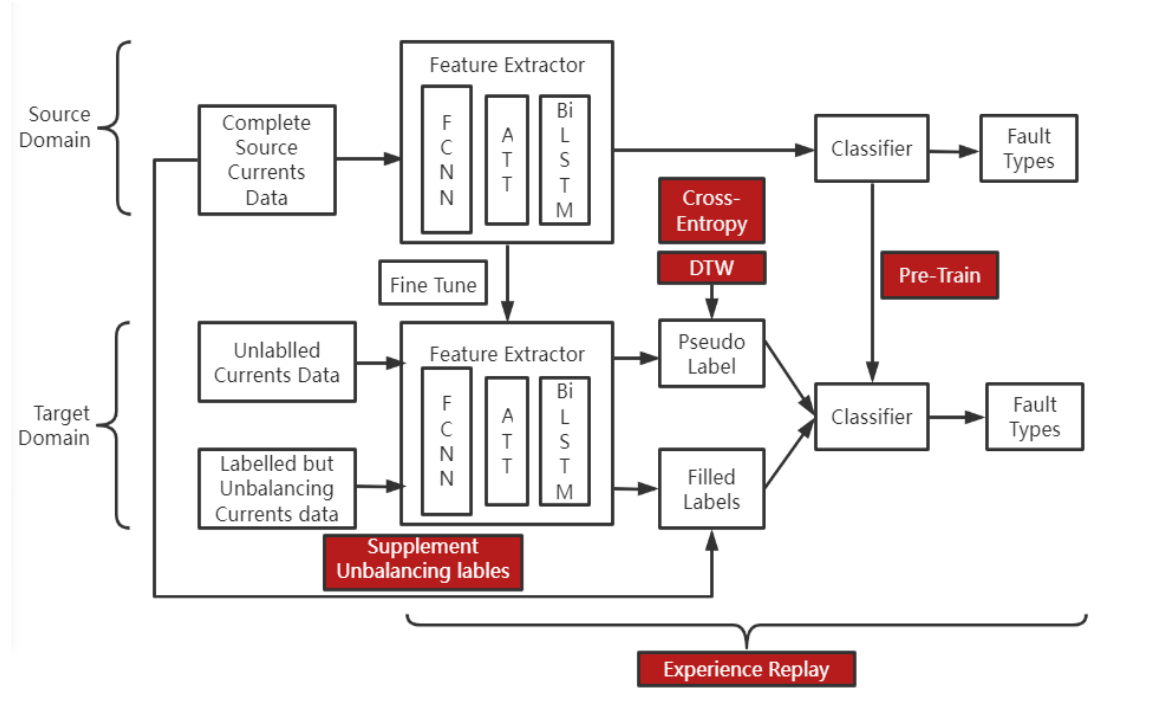
Figure 5. The framework of adaptive reinforcement